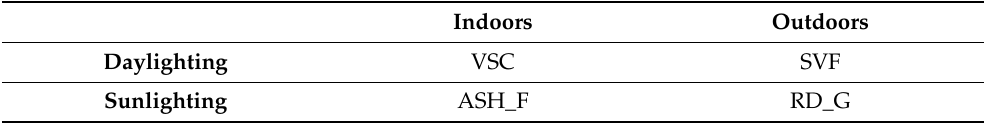
Table 5. Suggested metrics that may be suitable for early assessments of solar access at the urban planning